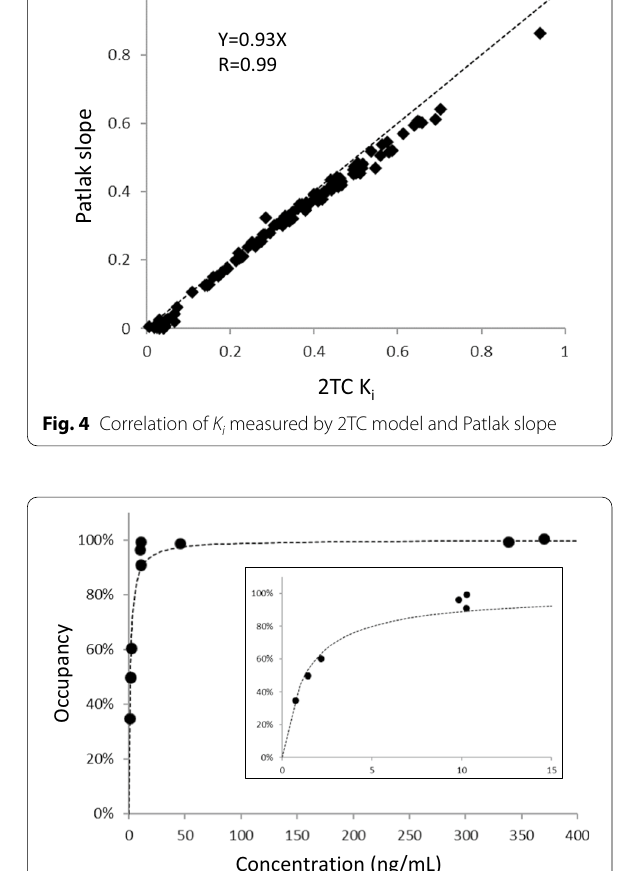
Fig. 5 Relationship between plasma concentration of PF-06807893 and MAGL